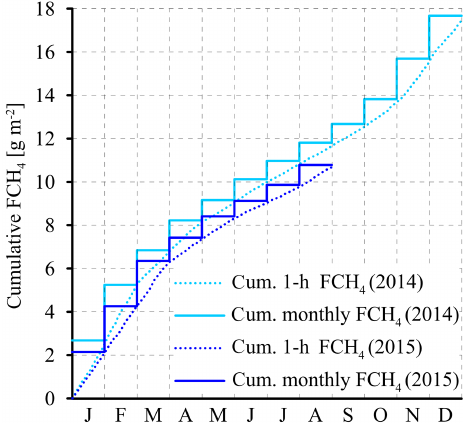
Figure 6. Cumulative fluxes of FCH 4 in the period January– December 2014 (light blue lines) and January–August 2015 (dark blue lines). Dotted and solid lines indicate cumulative annual FCH 4 calculated, respectively, on the basis of all 1h data and on the basis of integrated mean daily courses of consecutive months.